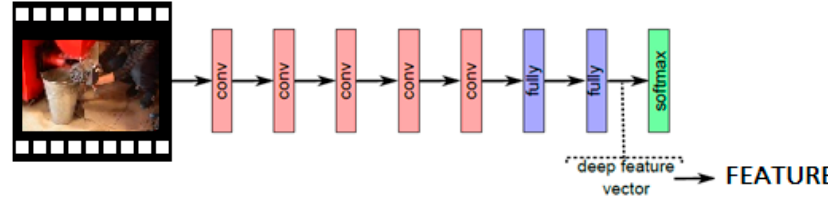
Figure 2. The idea of extracting a feature vector for a frame.